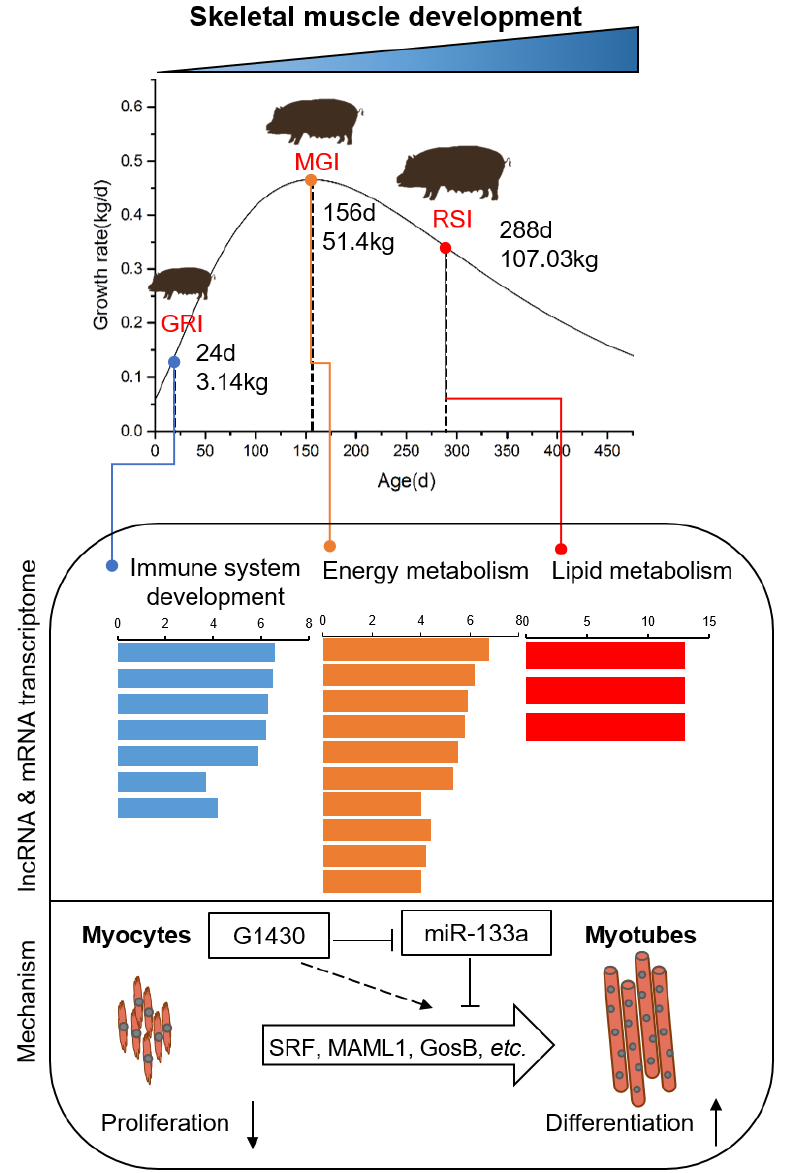
Figure 7. Graphic for lncRNA transcriptome analysis and reasonably speculated mechanism of lncRNA G1430 in skeletal muscle of Qingyu pigs.